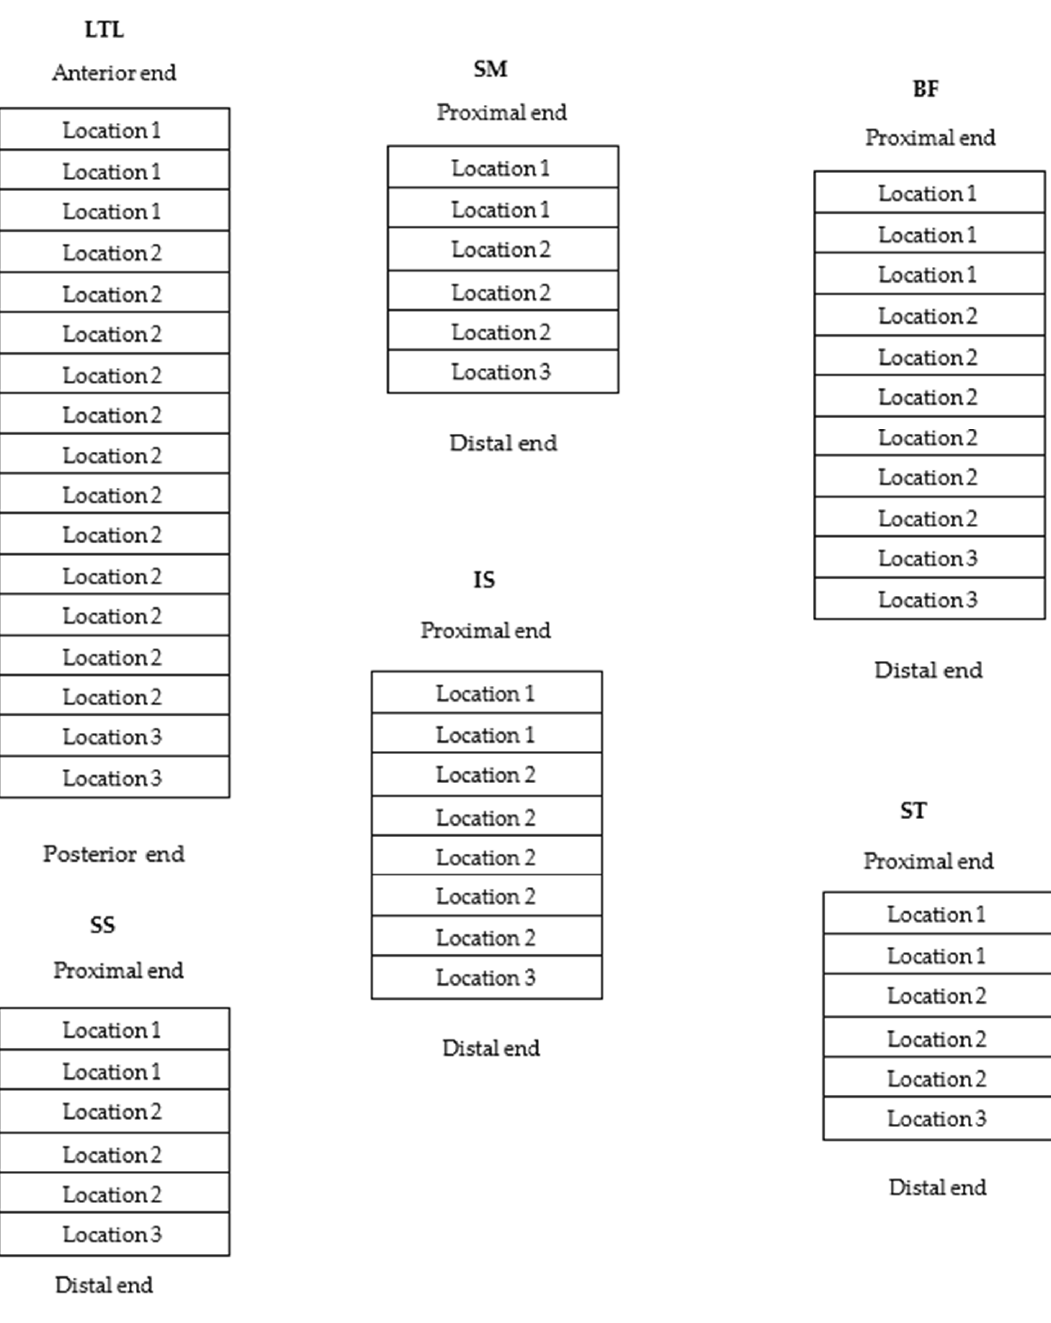
Figure 2. Sampling locations of the six different muscles (i.e., Longissimus thoracis et lumborum (LTL), Semimembranosus (SM), Biceps femoris (BF), Supraspinatus (SS), Infraspinatus (IS), and Semitendinosus (ST)). Left side of carcass for day 1 samples for location 1 (meat colour, water-holding capacity, myofibril fragment length), location 2 (Warner-Bratzler shear force) and location 3 (collagen analysis total and soluble); Right side of carcass for day 4 samples for location 1 (meat colour, water holding capacity, myofibril fragment length), location 2 (Warner-Bratzler shear force) and location 3 (collagen analysis-total and soluble, proximate analysis). Proximal = nearest to the vertebral column. Each horizontal section represents a 2.0 cm-thick slice.